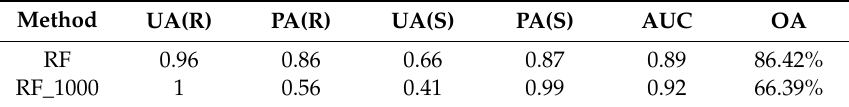
Table 4. The performances of the No. 3 model by using the RF method with the cost of 1000, where OA, AUC, PA, UA, S, and R represent overall accuracy, the area under ROC curve, producer’s accuracy, user’s accuracy, landslide source, and runout,